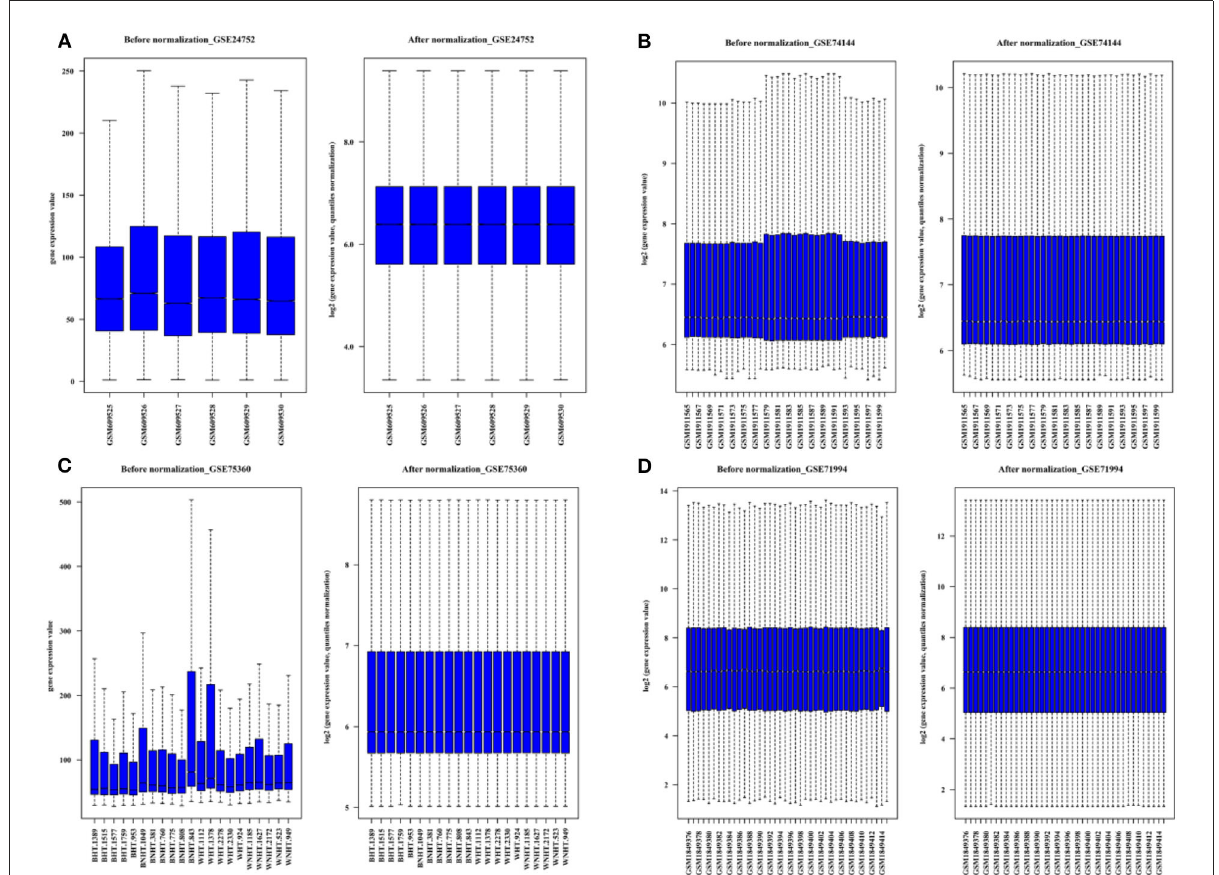
FIGURE2 The boxplots for the microarray dataset prior and subsequent to normalization. (A) GSE 24752: Normotensive ( n = 3) and hypertensive ( n = 3). (B) GSE75360: Normotensive ( n = 11) and hypertensive ( n = 10). (C) GSE74144: Hypertensive patient with normal left ventricular ( n = 14), hypertensive patient with left ventricular remodeling ( n = 14) and control (n = 8). (D) GSE71994: Controlled hypertensive ( n = 20), and uncontrolled hypertensive ( n =